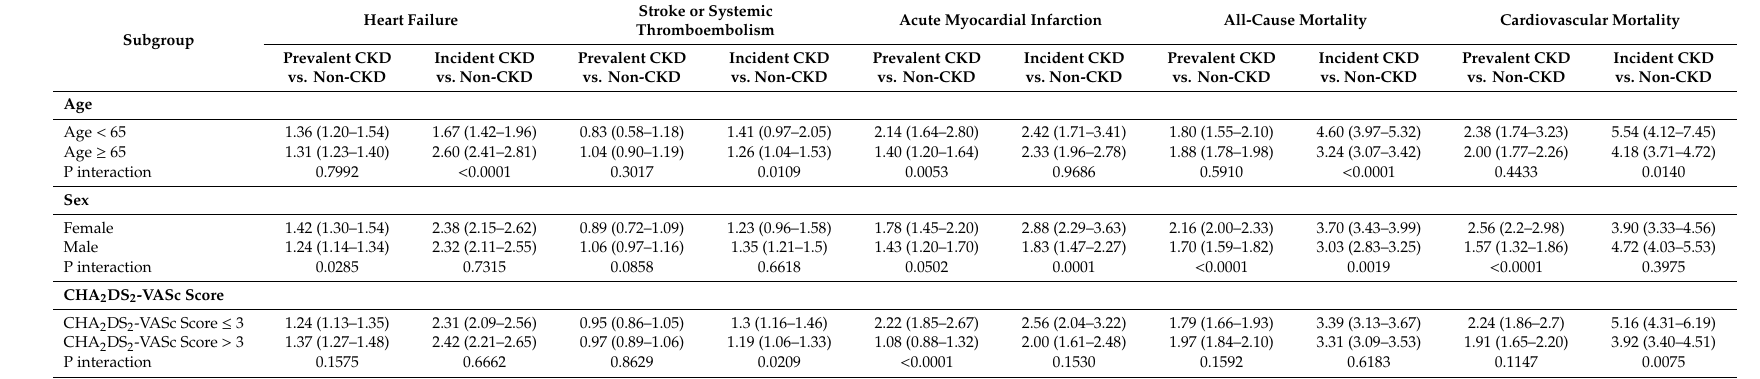
CKD, chronic kidney disease. aHR was calculated from adjustment for all variables in Table